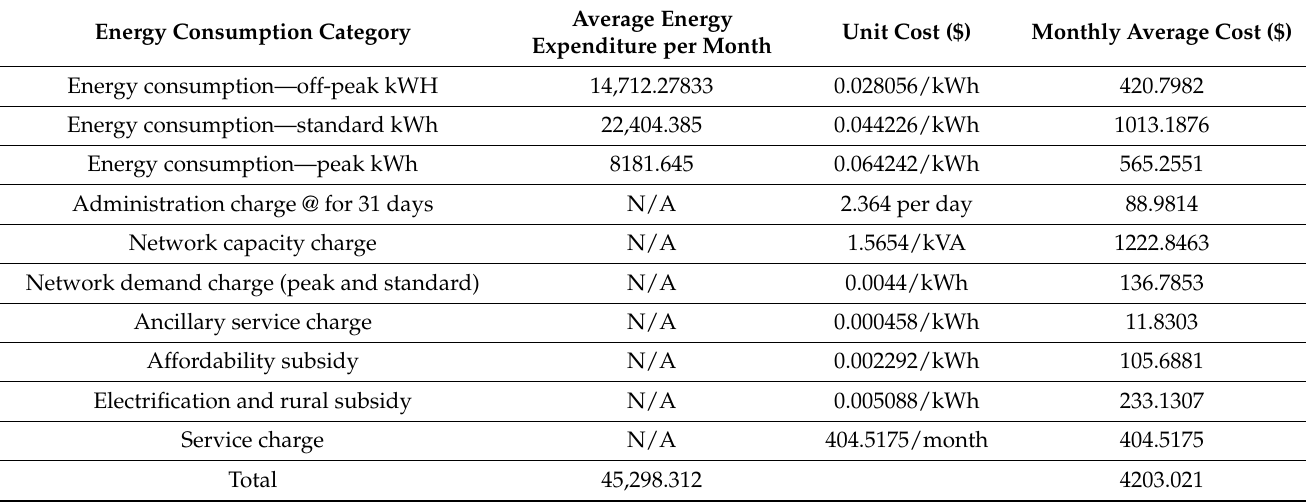
Table 4. Monthly Energy consumption and